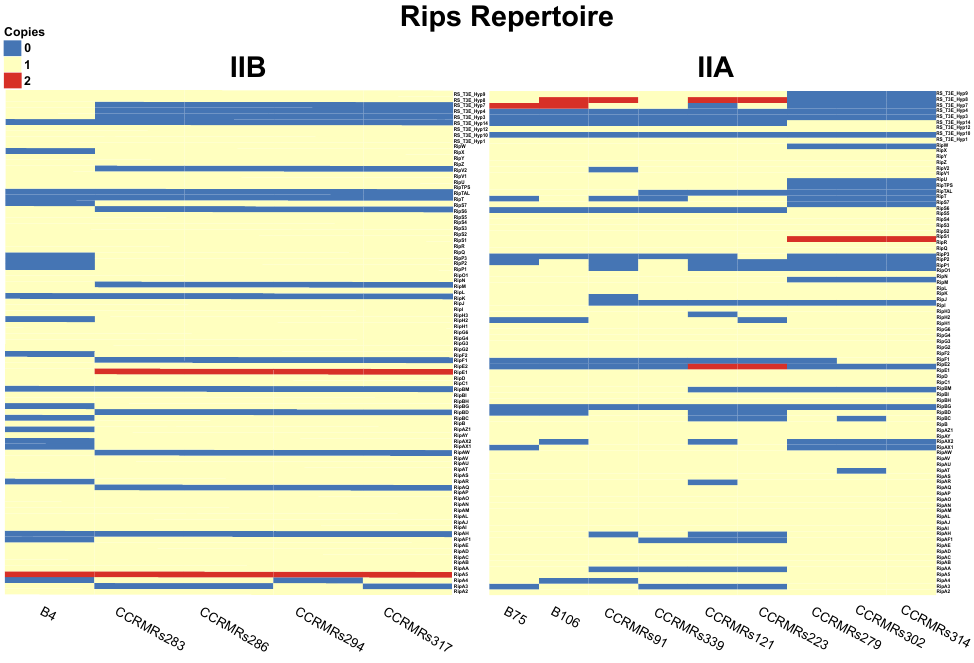
Figure 9. Heatmap of Rips repertoire of each new Brazilian R. solanacearum isolates IIB ( left ) and IIA ( right